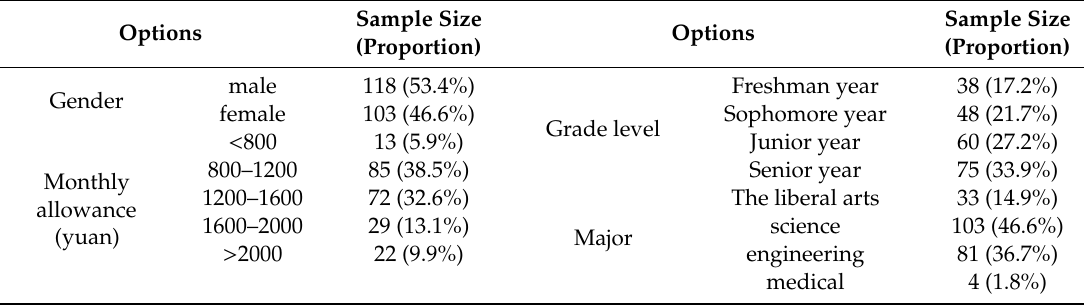
Table 1. Basic respondent